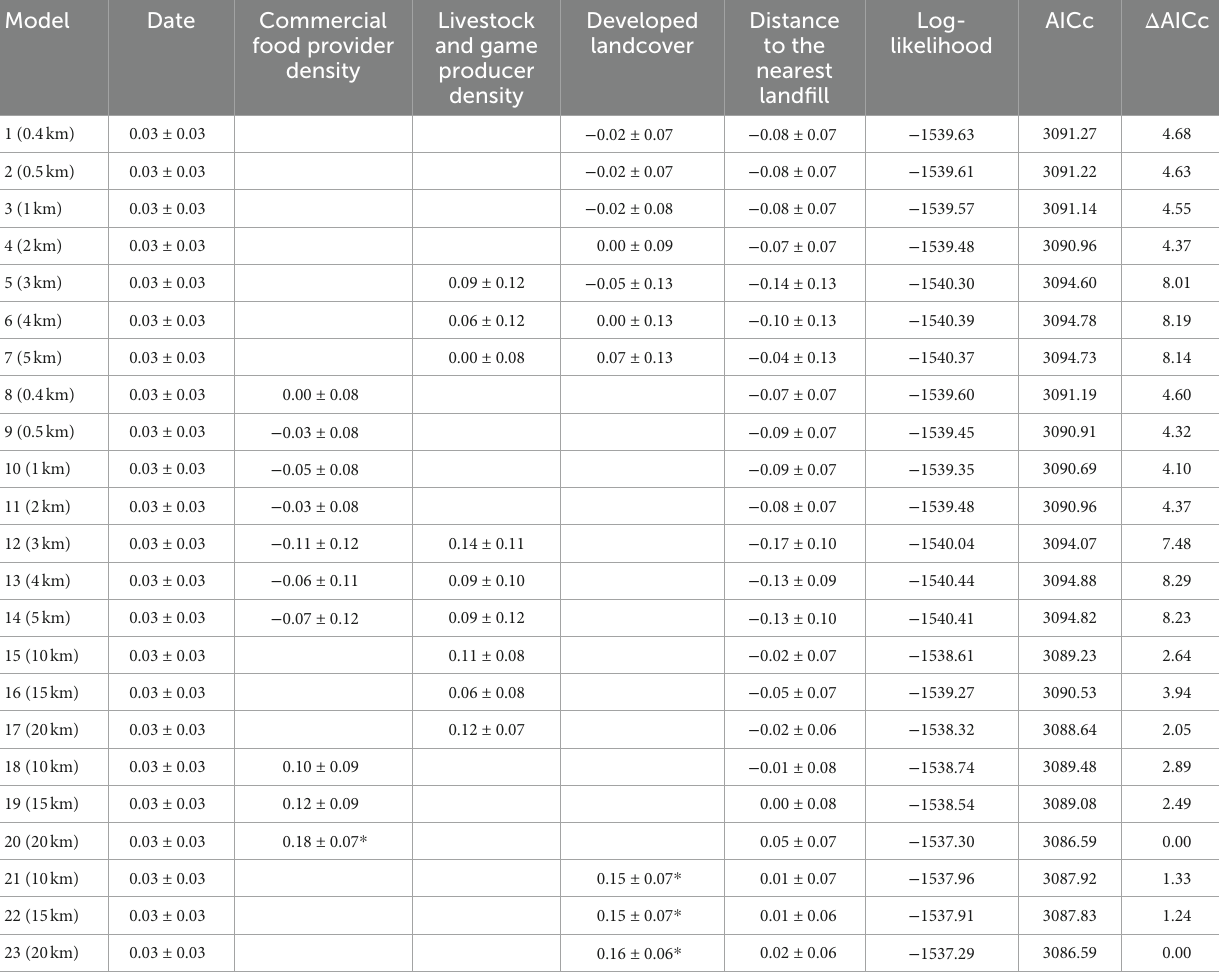
TABLE 1 Variable estimates (± SE) of models describing the plastic composition of black vulture ( Coragyps atratus ) and turkey vulture ( Cathartes aura ) pellets in the Charlotte Metropolitan Area, United States.